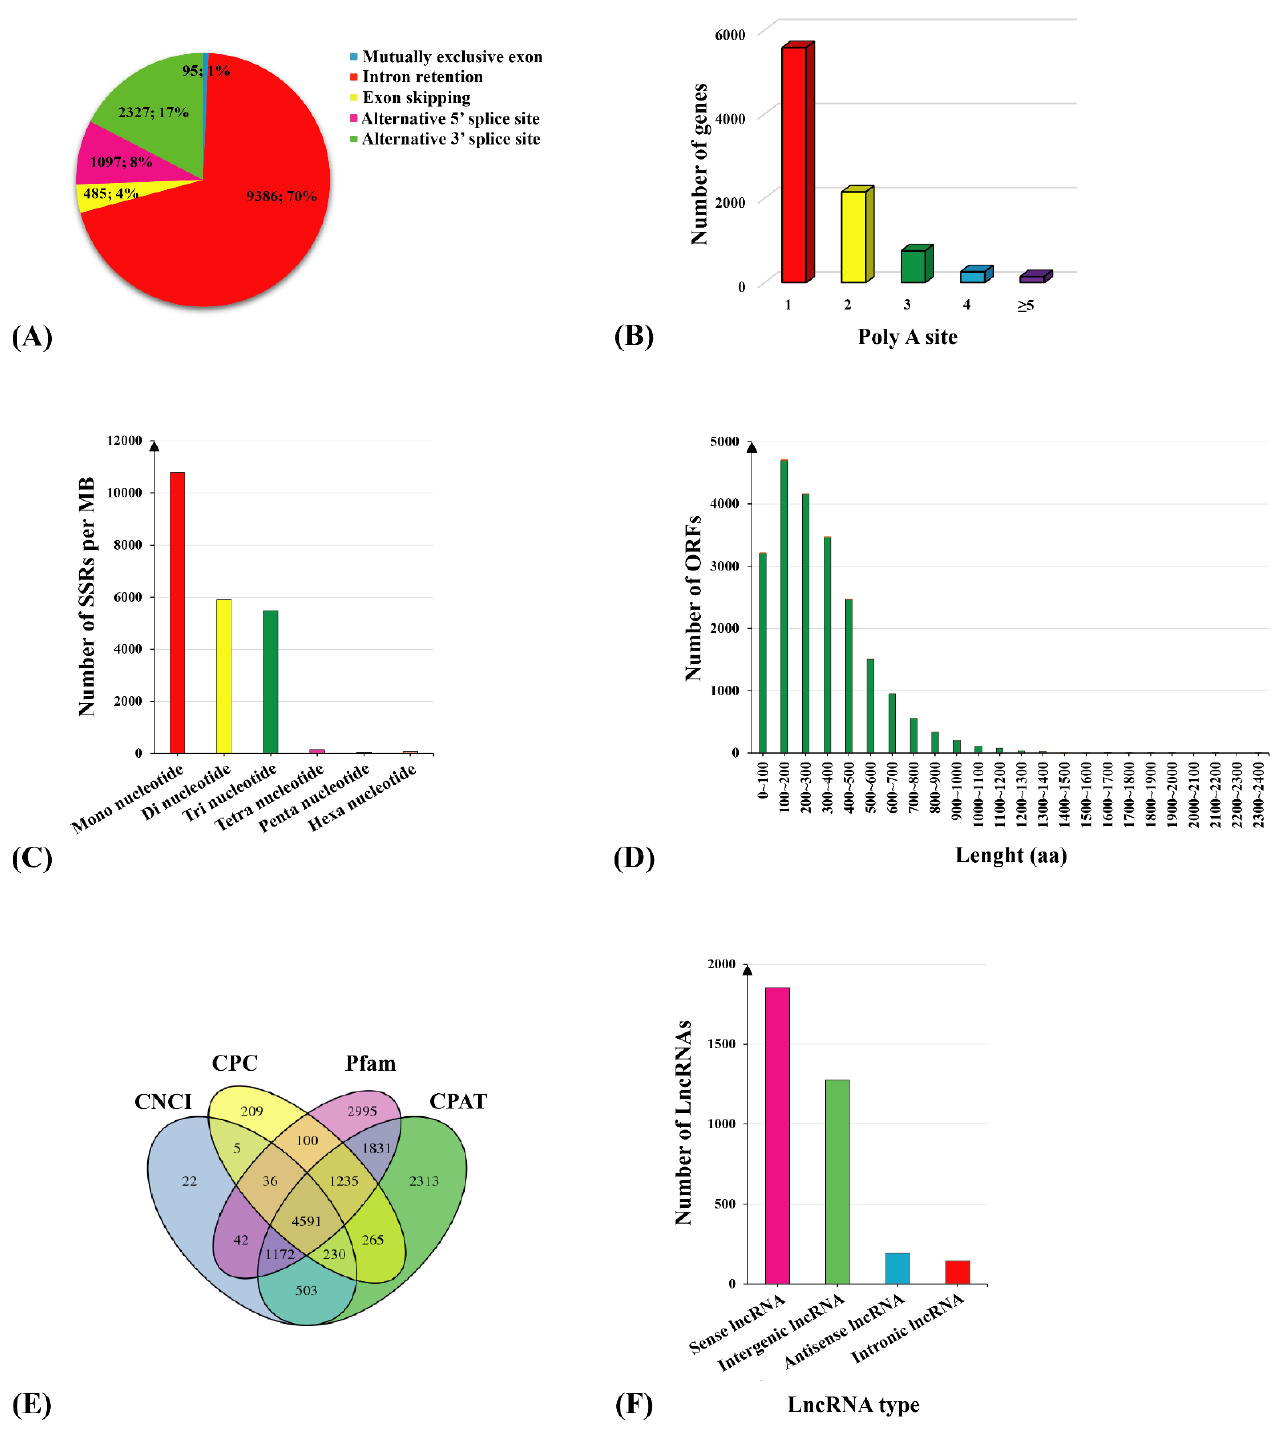
Figure 4. Prediction of AS, APA, SSR, ORF, and lncRNA events. ( A ) Number statistics of AS events. ( B ) Number statistics of the APA sites. ( C ) Density analysis of the SSR type. ( D ) Distribution map of the ORF–encoded protein length. ( E ) Venn diagram of LncRNA screening methods. ( F ) Classification map of the lncRNA location.